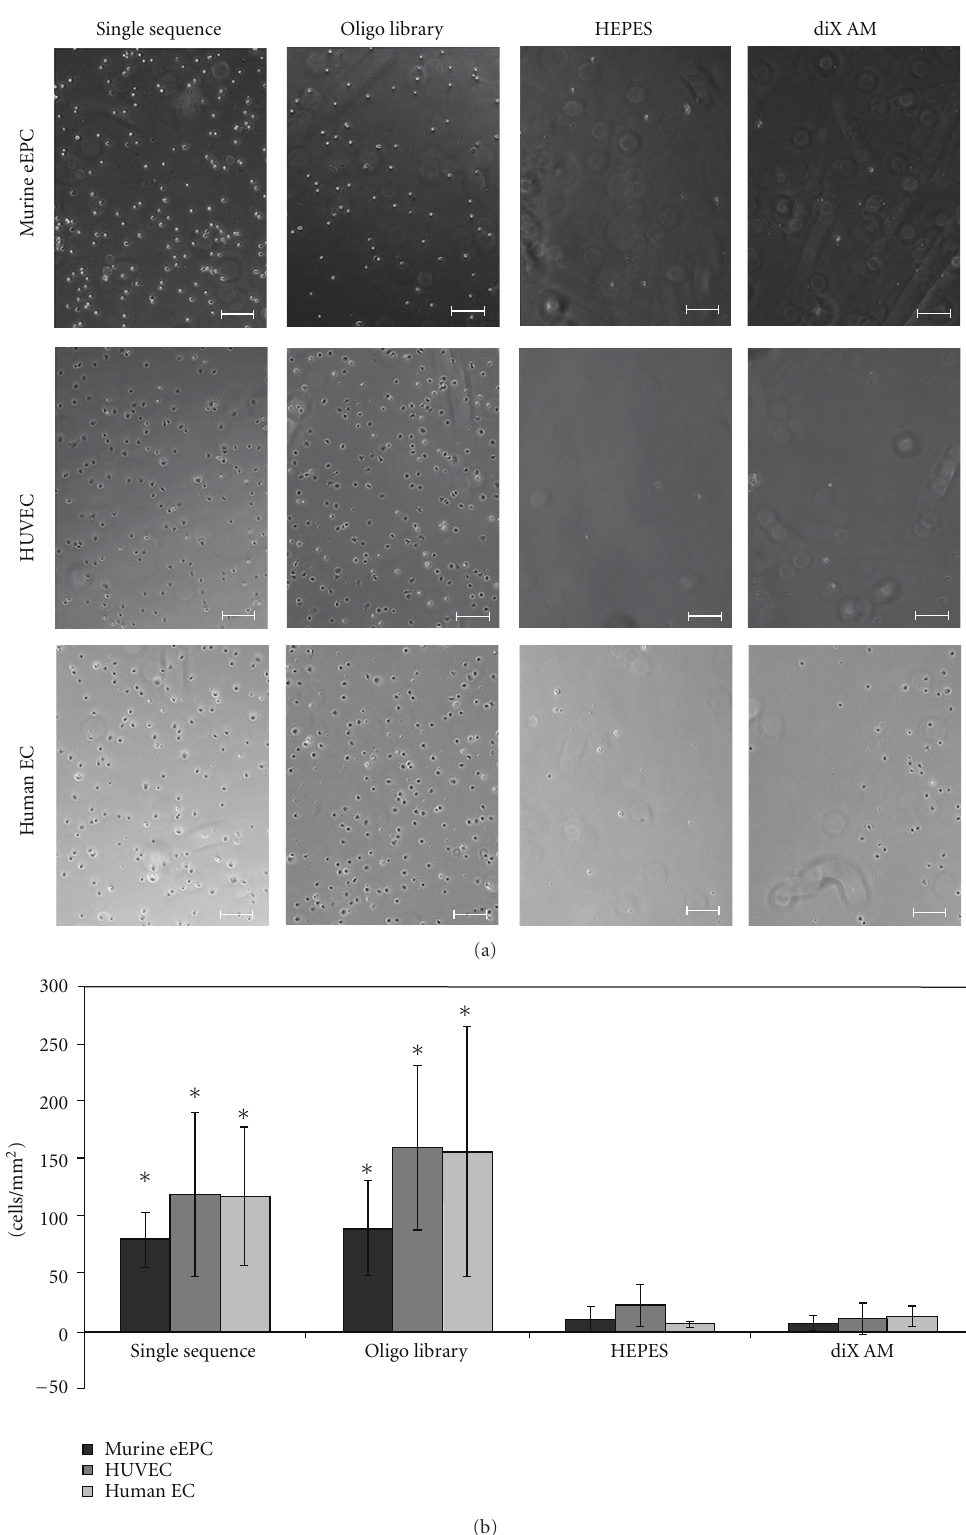
Figure 5: Cell adhesion to oligonucleotide-coated diX AM surfaces in FCS containing medium under dynamic conditions. Samples were incubated with 0,05 ∗ 10 6 cells for 1 h in corresponding medium containing FCS. (a): Scale bar equals 200 μ m. (b): Number of adhered cells per mm 2 was counted in microscopy images ( n = 6). Groups marked with ∗ are significantly di ff erent to HEPES and diX AM samples ( P < 0 .